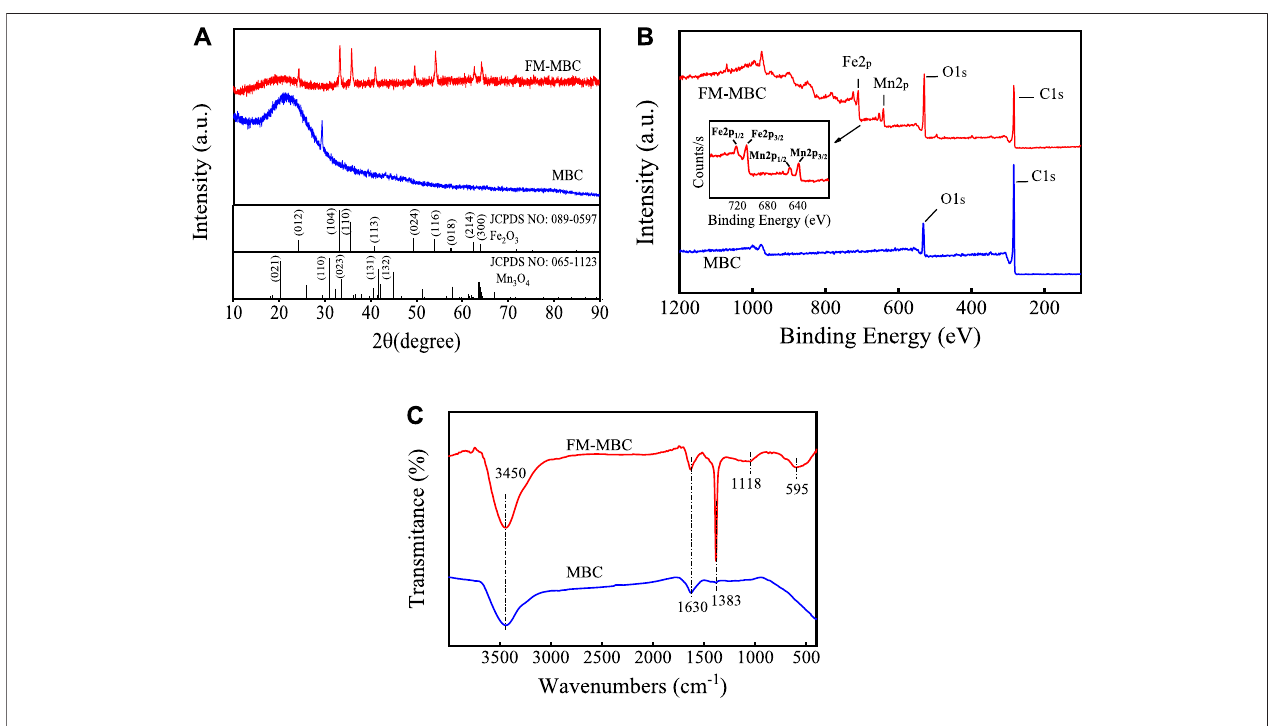
FIGURE 3 | Spectra of MBC and MBC-MFC. (A) XRD, (B) XPS, and (C) FT-IR.